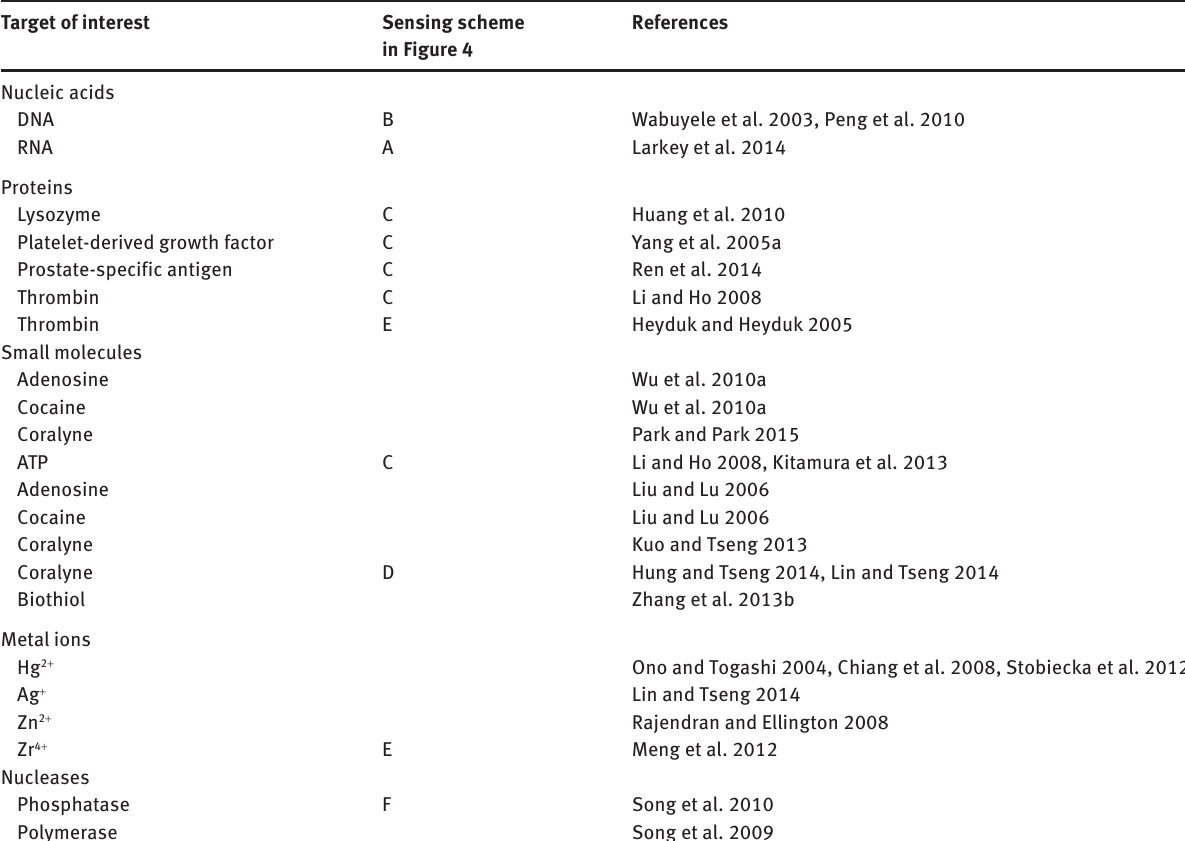
Table 3: MB-based “close-to-signal” schemes for sensing various